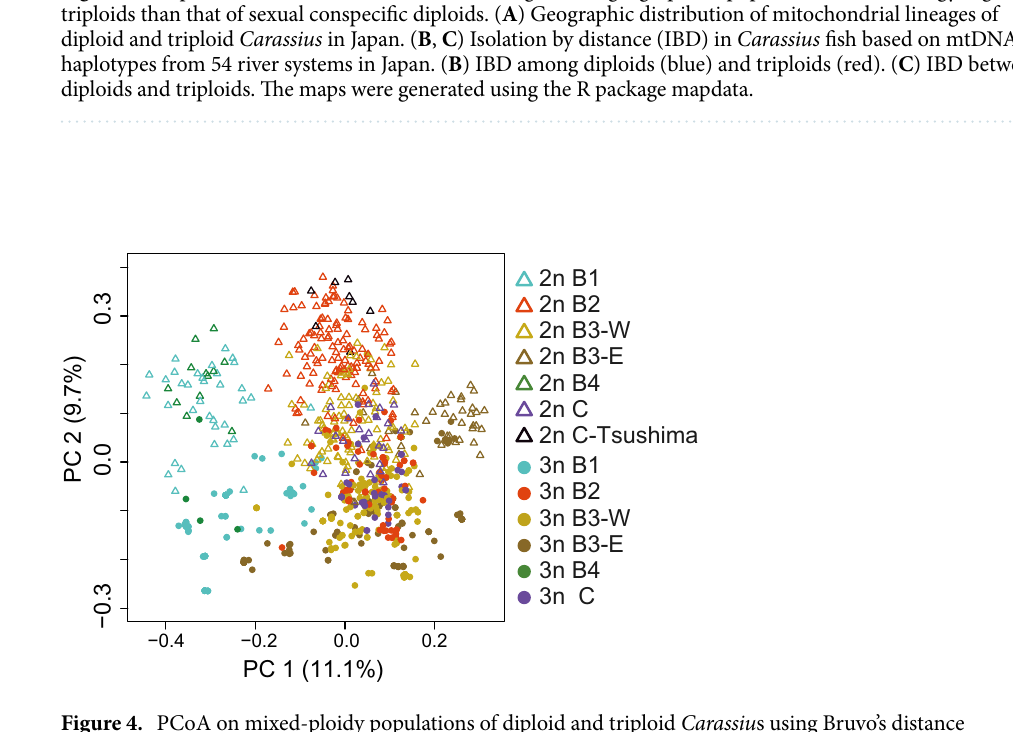
Figure 4. PCoA on mixed-ploidy populations of diploid and triploid Carassiu s using Bruvo’s distance performed in POLYSAT. Triangles indicate diploids, and circles represent triploids, with colors corresponding to the mitochondrial lineages of the